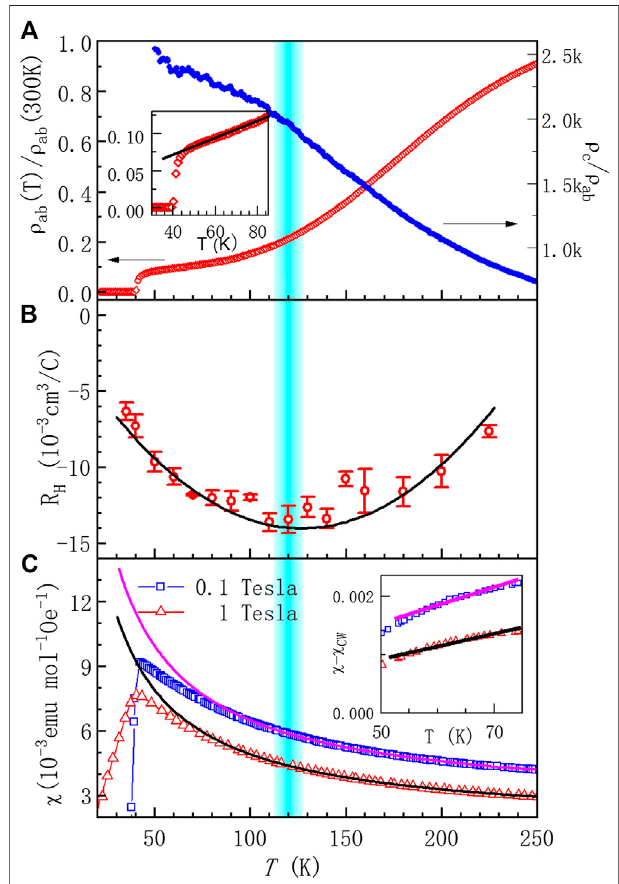
FIGURE 3 | The electrical transport and magnetic properties of (Li 0.84 Fe 0.16 )OHFe 0.98 Se single crystal [58]. (A) The in-plane electric resistivity and the ratio ofout-of-plane to in-plane resistivity as functions of temperature. The inset shows the linear resistivity below the Hall-dip temperature T* down to T c . (B) The temperature dependence of in-plane Hall coef fi cient shows a dip-like feature around T* ∼ 120 K. (C) The temperature dependencies of static magnetic susceptibility under magnetic fi elds along c -axis.AdeviationfromtheCurie-WeisslawisclearlyvisiblebelowtheHall-dip temperature T* . Aftersubtracting the Curie-Weiss term (the solid fi ttedcurves) from the (Li 0.84 Fe 0.16 )OH-blocks, a nearly linear magnetic susceptibility from the FeSe-blocks is obvious (the inset).